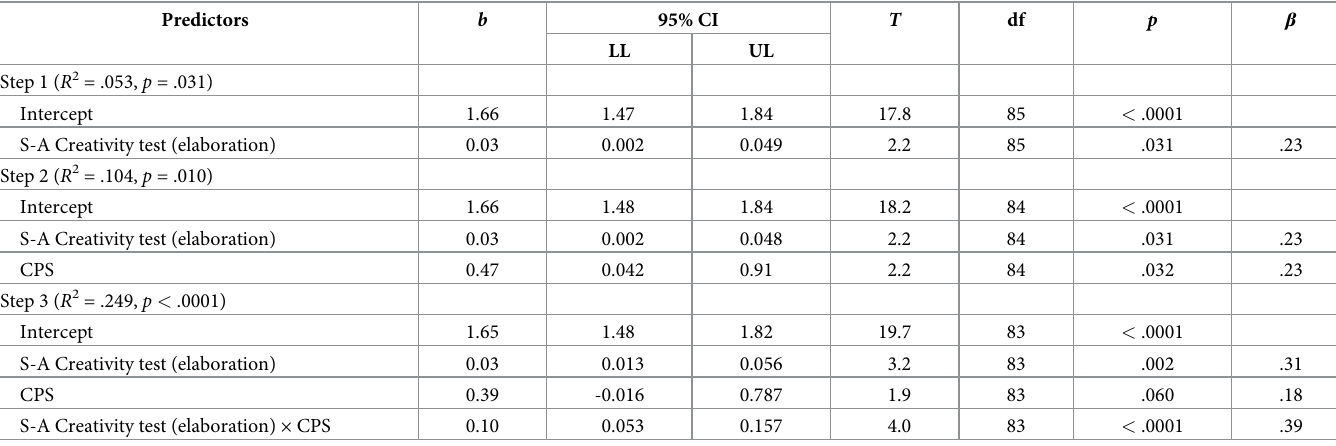
Table 6. Results of multiple regression analysis in the effect of elaboration with creative achievement score as the objective variable.